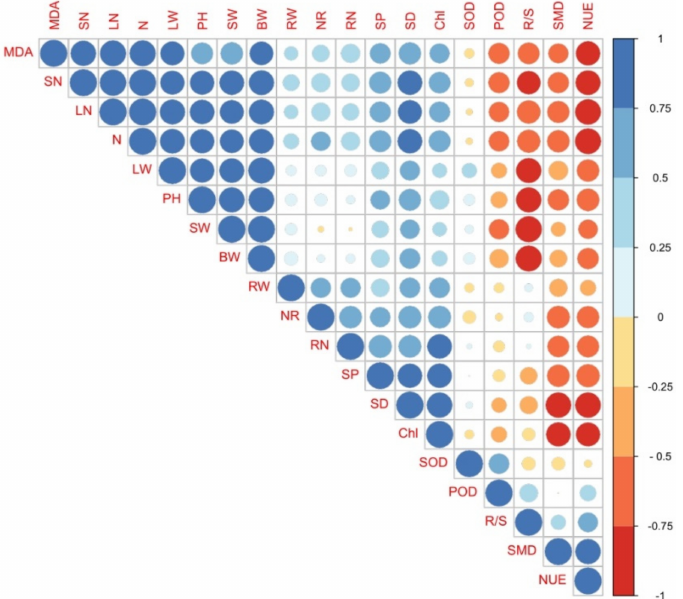
Figure 5. Correlation between studied parameters of growth, antioxidant capacity, and N accumula- tion in hemp. PH, plant height; SD, stem diameter; LW, leaf weight; SW, stem weight; RW, root weight; BW, biomass weight; R/S, root to shoot ratio; SMD, stem mass density; Chl, chlorophyll content; SP, soluble protein; NR, nitrate reductase activity; SOD, superoxide dismutase; POD, peroxidase; MDA, malondialdehyde; RN, root nitrogen; SN, stem nitrogen; LN, leaf nitrogen; N, total nitrogen; NUE, nitrogen use